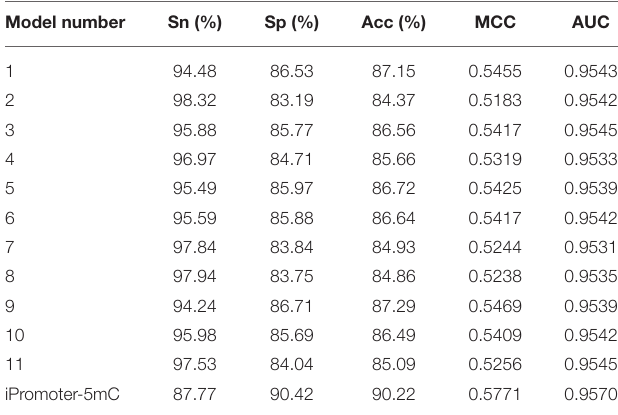
TABLE 3 | The performance of iPromoter-5mC based on the independent dataset. Model number